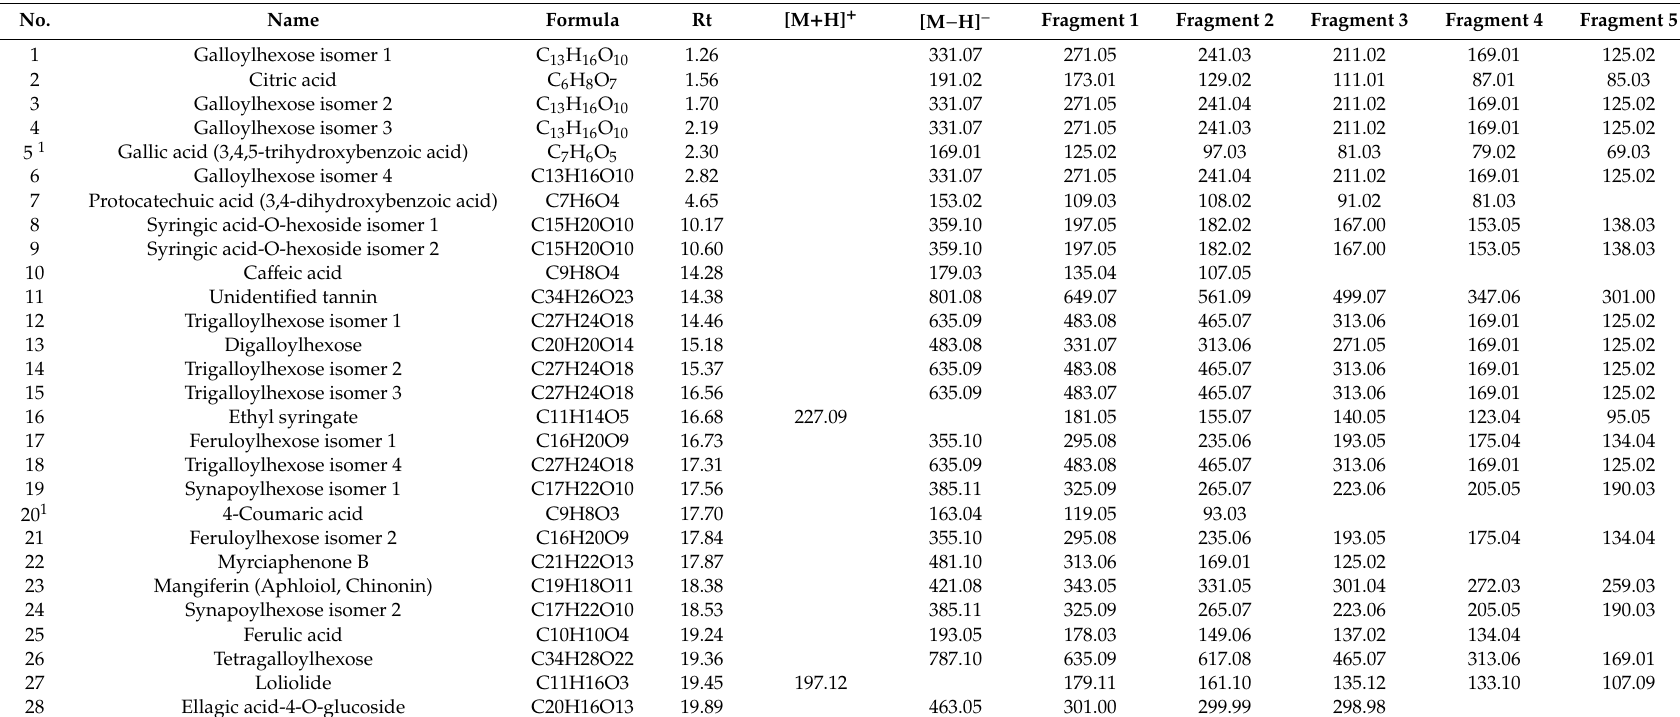
Table 4. Chemical composition of ethyl acetate